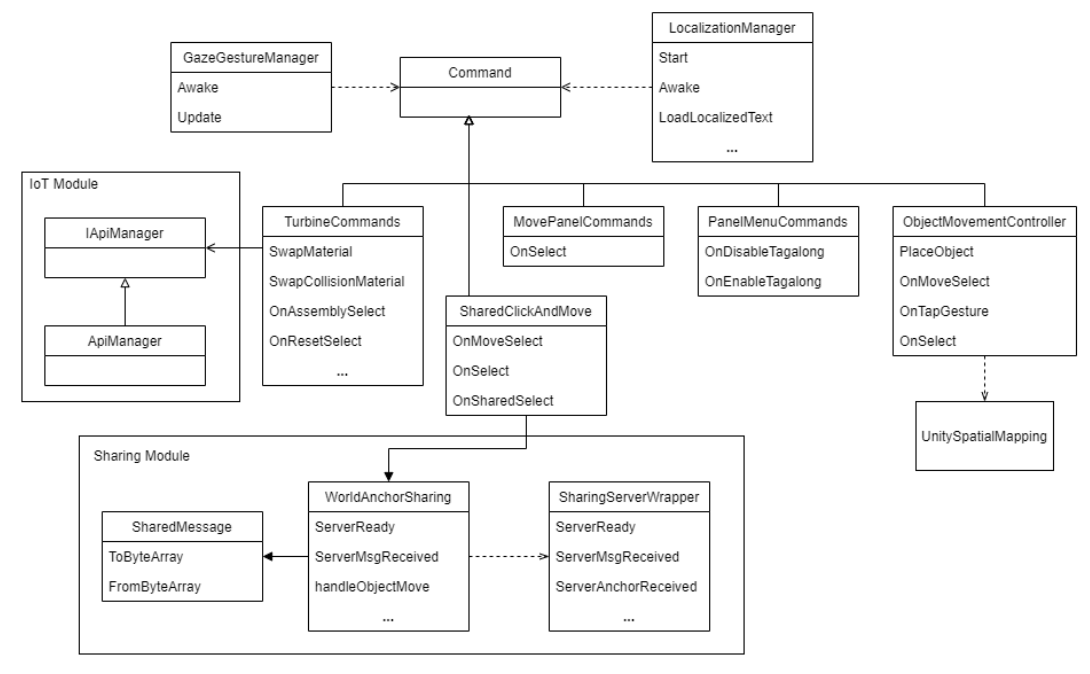
Figure 6. Simplified class diagram of the main components of the